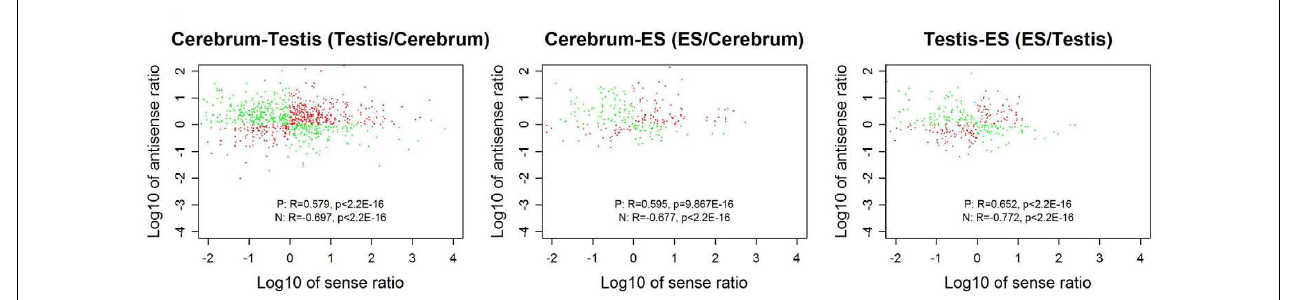
FIGURE 6 |The correlation between sense and antisense expression ratio in sense–antisense gene pairs. Red and green points represent the sense–antisense gene pairs in positive and negative types. “P” stands for the positive type and “N” stands for the negative